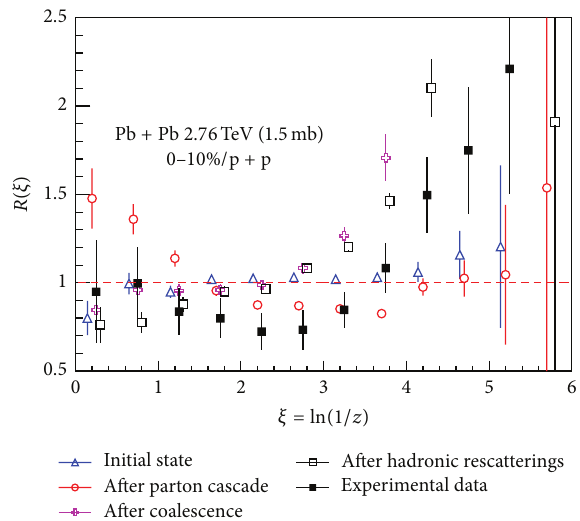
Figure 6: The jet fragmentation function ratios of the most central centrality bin (0–10%) in Pb + Pb collisions to p + p collisions at different evolution stages. The solid squares represent the data from the CMS experiment [14]. Some points are slightly shifted along the 𝑥 -axis for better